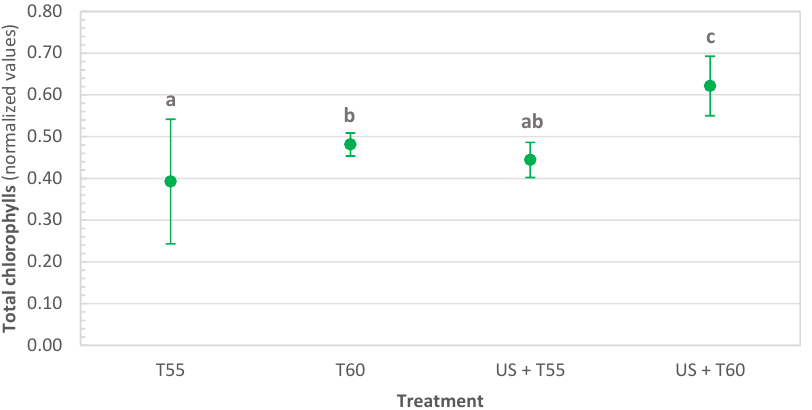
Figure 3. Effect of thermal and thermosonication treatments on total chlorophylls in kiwi peel (normalized values in relation to untreated samples). Values with different letters differ significantly ( p < 0.01).